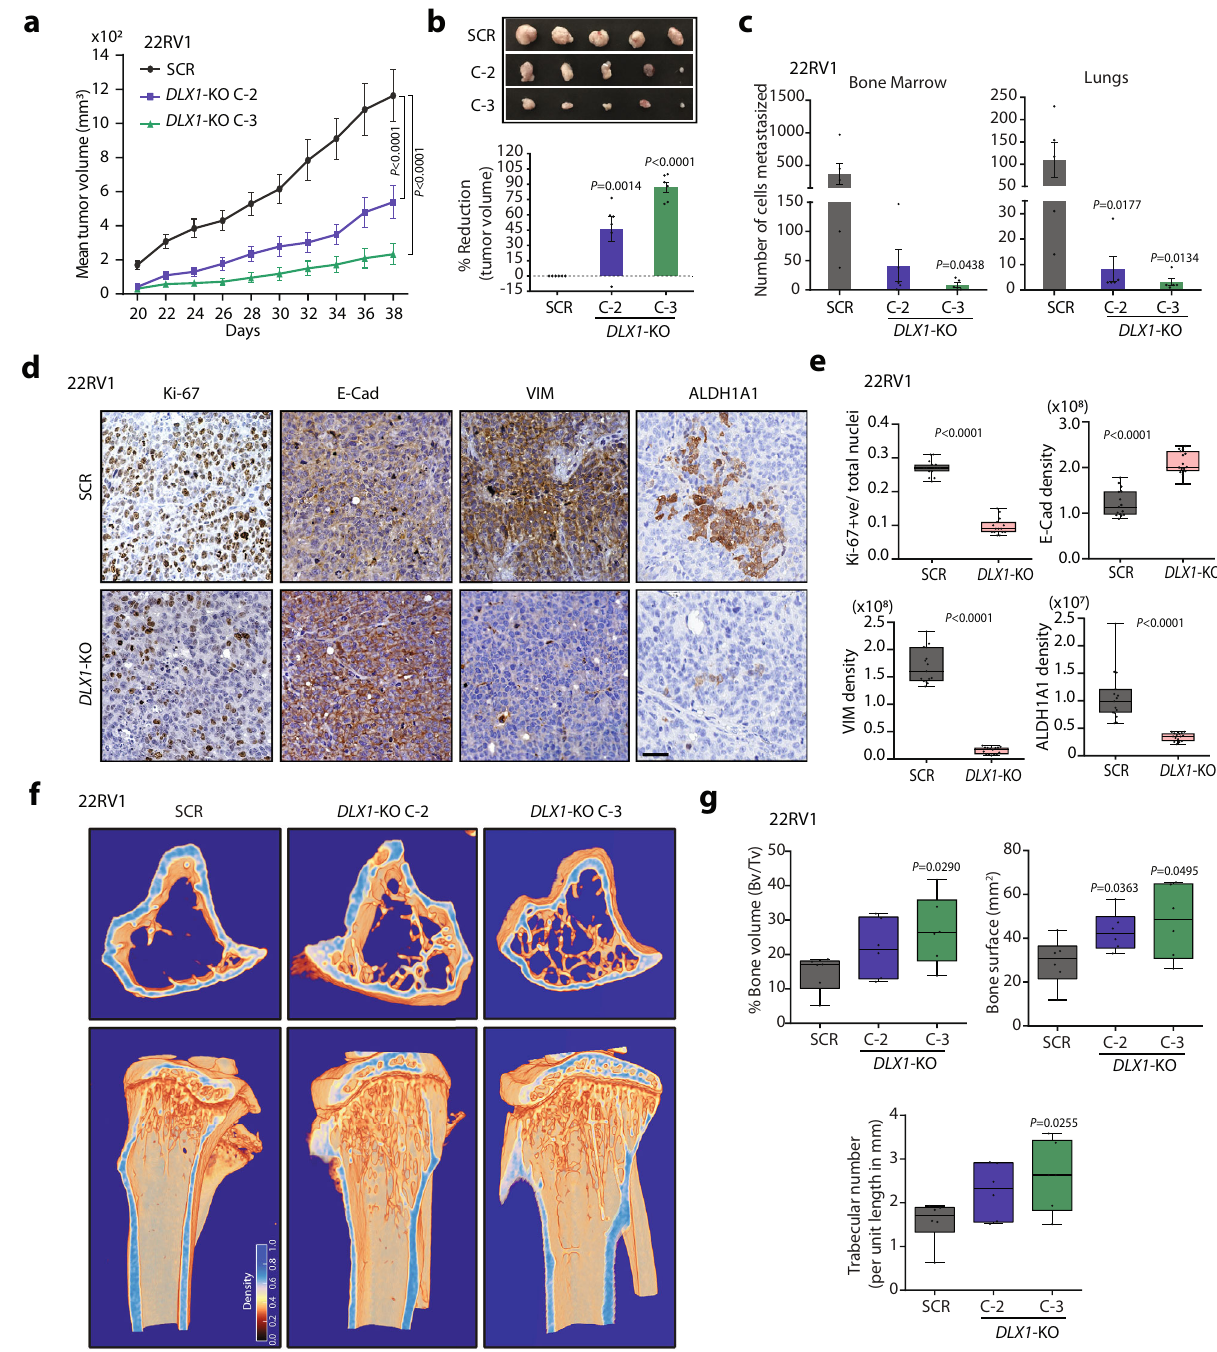
Fig. 3 Abrogating DLX1 expression results in tumor regression and reduced metastases. a Mean tumor volume of 22RV1- DLX1 -KO and control SCR cells subcutaneously implanted in NOD/SCID mice ( n = 6, P < 0.0001). b Representative images of the tumors excised at end of the xenograft experiment (top panel). Bar graph showing relative percent reduction in tumor burden. c Bar graphs representing number of cells metastasized to the bone marrow and lungs in xenografted mice as labeled ( n = 5). d Images depicting immunostaining for Ki-67, E-cadherin (E-Cad), Vimentin (VIM), and ALDH1A1 on xenograft tumor sections, images are representative of three tissue samples. Scale bar, 35 µ m. e Box plots showing immunostaining quanti fi cation of Ki-67, E-Cad, VIM, and ALDH1A1. Quanti fi cation was blindly done from 15 random histological fi elds ( P < 0.0001). f Representative microCT bone images showing horizontal section (top panel) and vertical cross-section (bottom panel) views of the tibia excised from mice ( n = 6) four weeks after intra- medullary tibia injection using 22RV1- DLX1 -KO and control cells. g Same as f , except box plots showing bone architecture parameters analyzed using CTAn software. For panels a , b and c , data represent mean ± SEM. For panels, a Two-way ANOVA, Dunnett ’ s multiple comparison test b , and c one-way ANOVA, Dunnett ’ s multiple comparison test; e Unpaired two-tailed Welch ’ s t -test; g Unpaired two-tailed Student t -test was applied. For panels, e and g Data are presented as box-and-whisker plots indicating median (middle line), 25th and 75th percentile (box) and minimum and maximum values (whiskers). Source data are provided as a Source Data fi